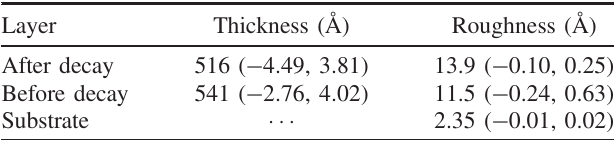
TABLE II. Diffraction peak positions obtained from the XRD scans performed on the photocathode before and after the decay. Diffraction 2 θ position before peaks decay